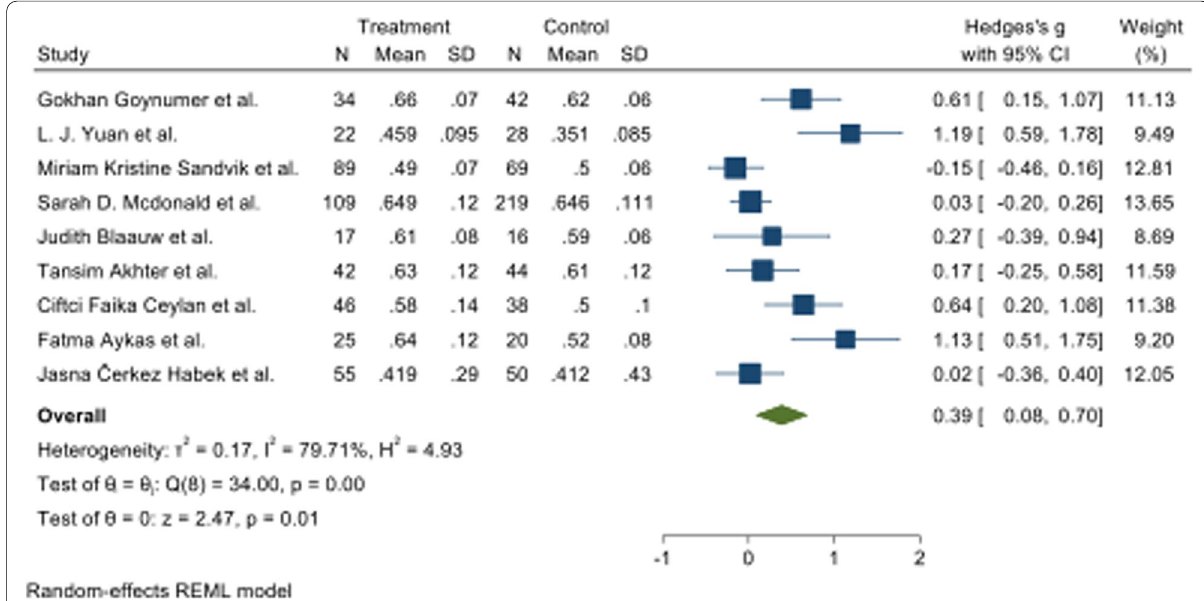
Fig. 3 Forest Plot for the effect of CIMT on